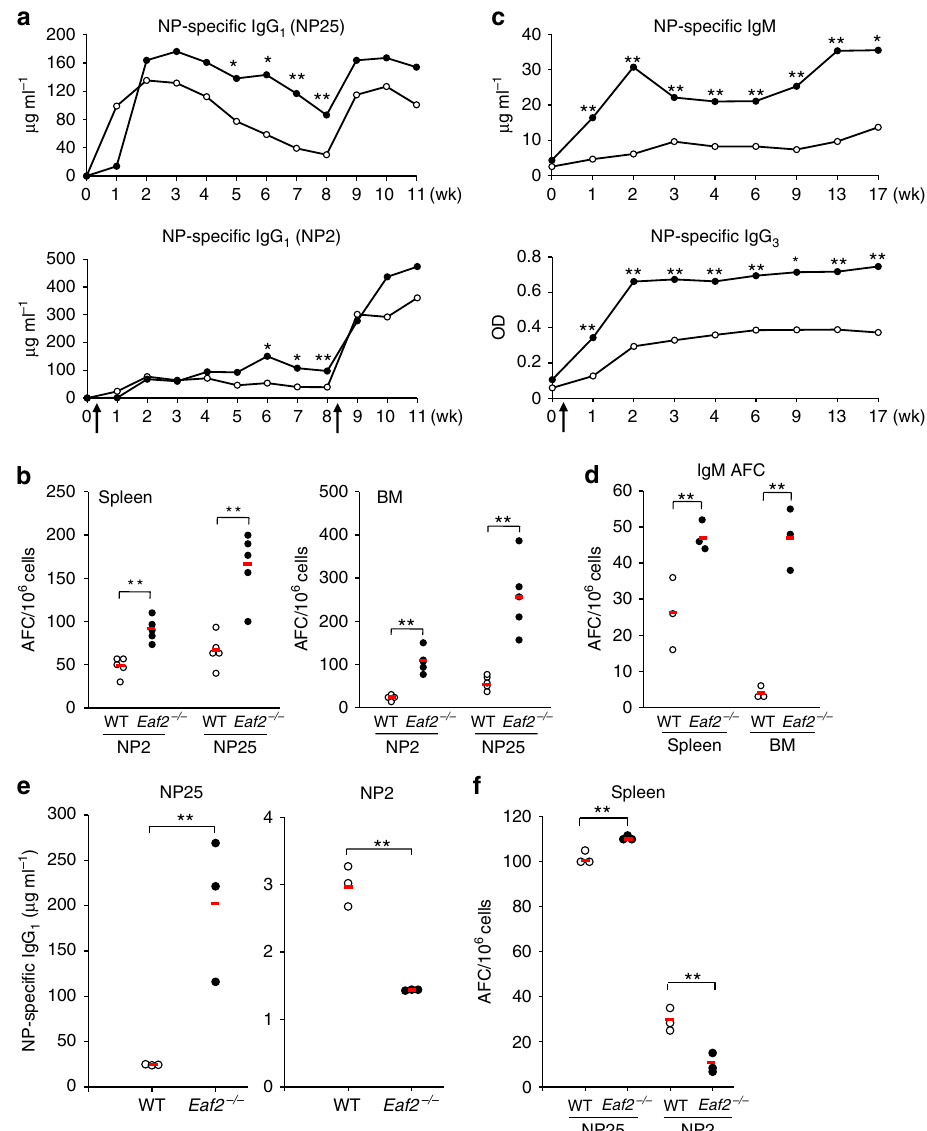
Figure 5 | Increased NP-specific Ab in immunized Eaf2 (cid:3) / (cid:3) mice. ( a ) Five pairs of WT and Eaf2 (cid:3) / (cid:3) mice were immunized with 10 m g of NP–CGG in alum. Serum levels of NP-specific IgG 1 Ab were measured with NP25-BSA (upper) and NP2-BSA (lower) at the indicated time points as described in Methods section. ( b ) AFC in spleen (left) and BM (right) at 6 weeks after NP–CGG immunization. NP2 and NP25 detect high affinity and total NP-specific AFC, respectively. ( c ) NP-specific IgM (upper) and IgG 3 (lower) serum Ab levels after immunization with NP-Ficoll. The results of five pairs of WT and Eaf2 (cid:3) / (cid:3) mice are shown. ( d ) NP-specific IgM AFC in the spleen and BM at 21 weeks after NP-Ficoll immunization. Three pairs of WTand Eaf2 (cid:3) / (cid:3) mice were analysed. ( e ) and ( f ), Rag1 (cid:3) / (cid:3) mice reconstituted with WT T þ WT B or WT T þ Eaf2 (cid:3) / (cid:3) B cells were immunized with NP–CGG and analysed for ( e ) NP-specific total IgG 1 Ab (NP25) and high-affinity IgG 1 Ab (NP2) in the serum and ( f ) AFC in the spleen. Open circles, Rag1 (cid:3) / (cid:3) mice reconstituted with WT T þ WT B cells; Solid circles, Rag1 (cid:3) / (cid:3) mice reconstituted with WT T þ Eaf2 (cid:3) / (cid:3) B cells. Arrows in a and c indicate immunization times. The red bar indicates the mean value of each group. * P o 0.05; ** P o 0.01 (unpaired t